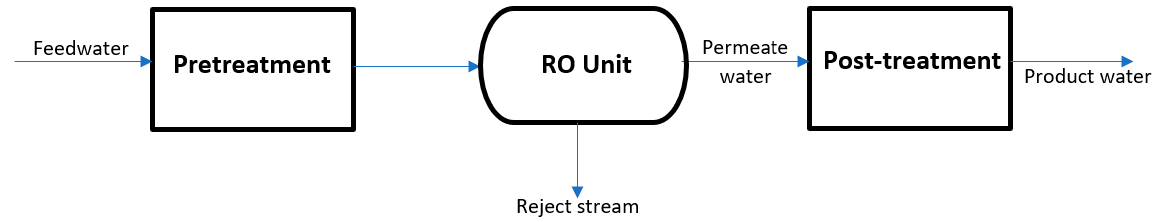
Figure 3. Reverse Osmosis process flow.